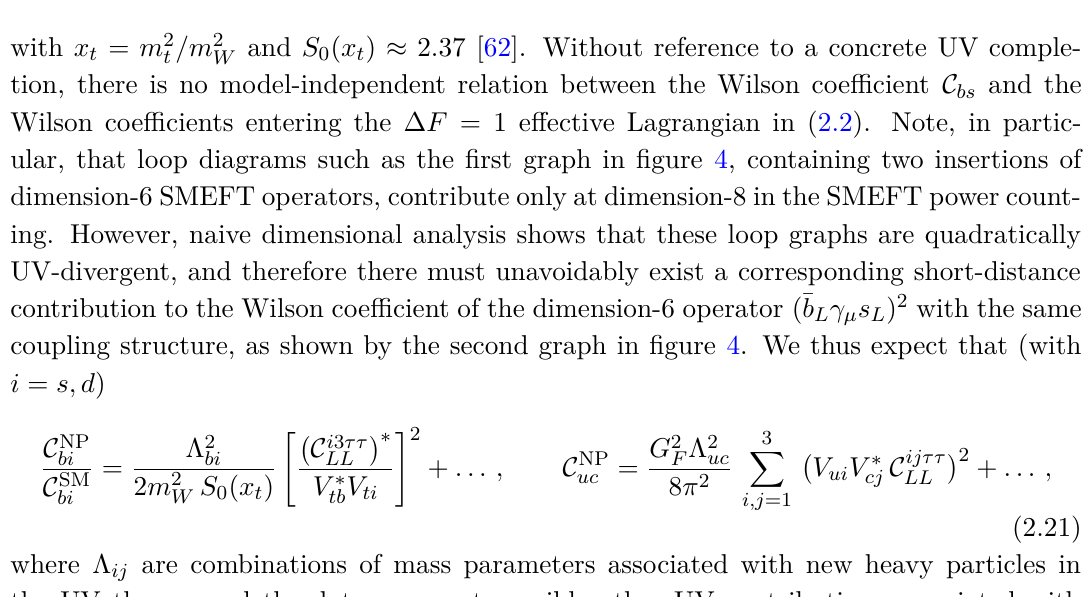
Figure 4 . Different NP contributions to B s - insertion of O 32 ττ